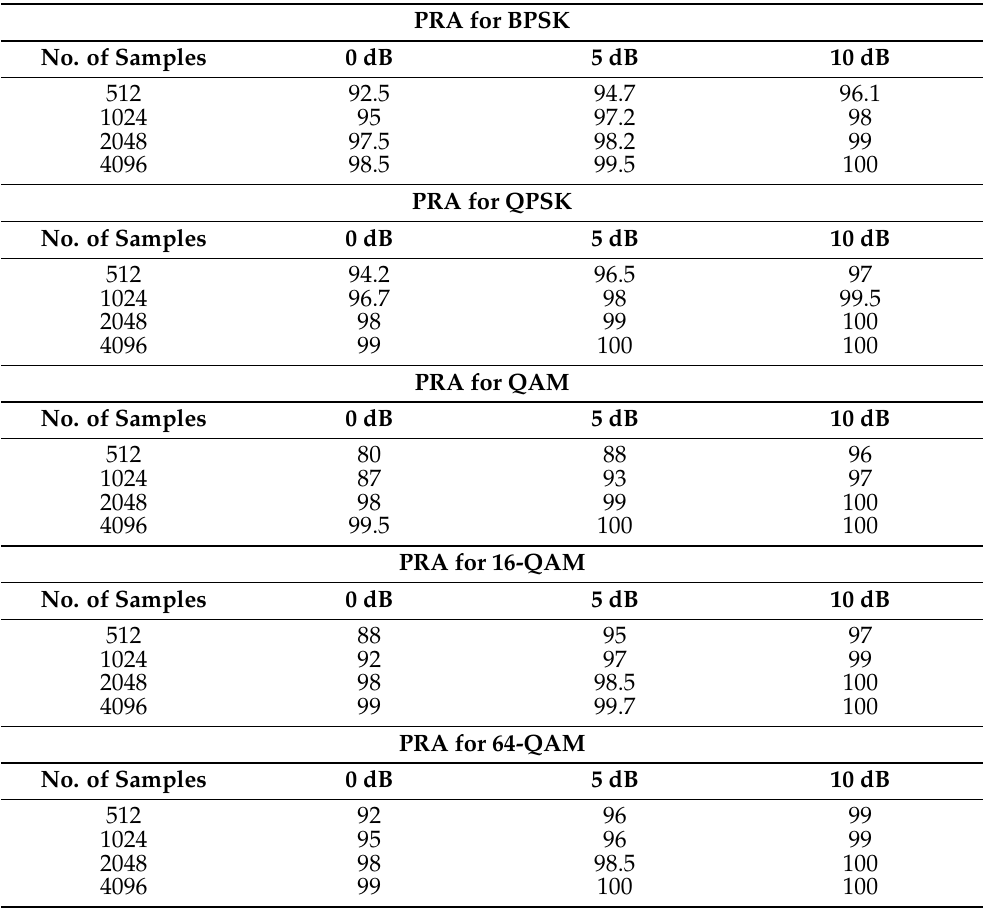
Table 5. Percentage recognition accuracy on the Rayleigh